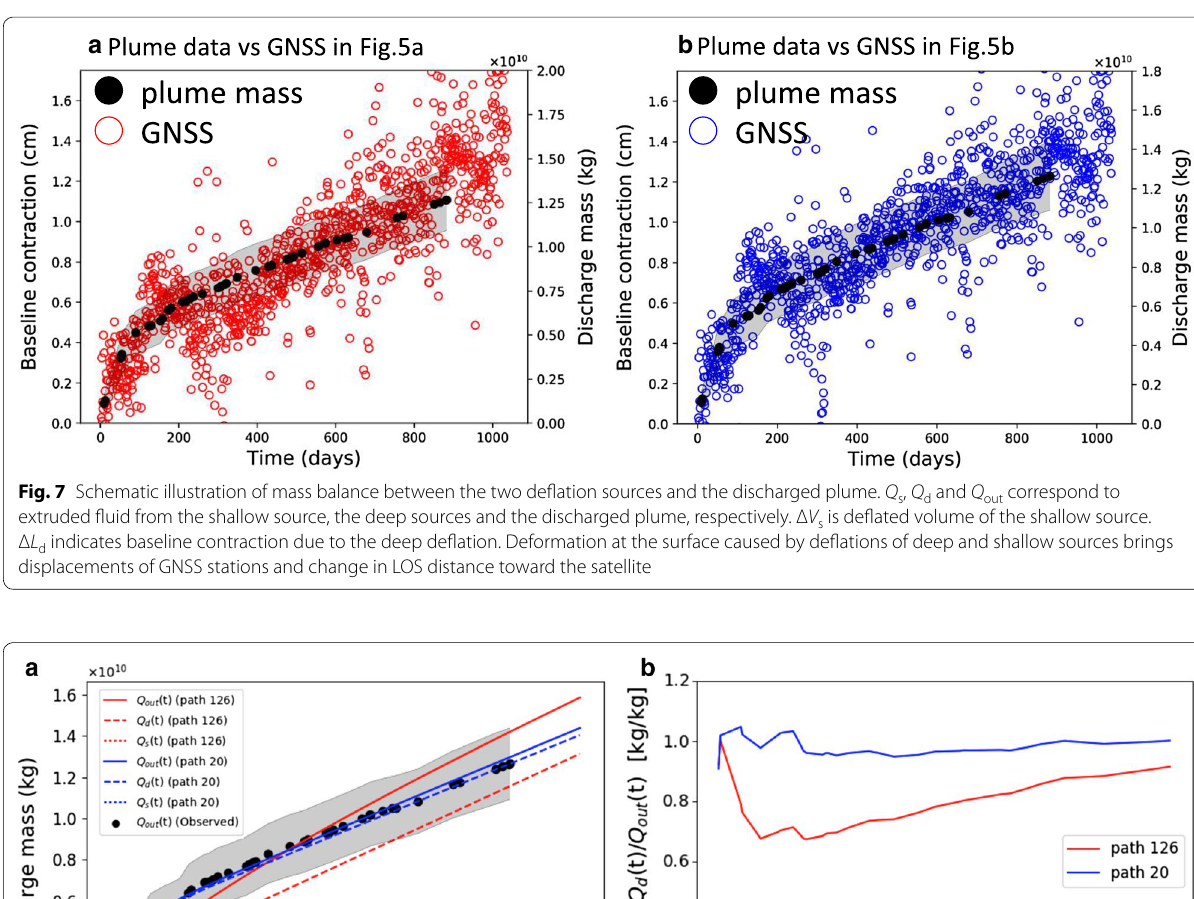
Q d ( t ) Q s ( t )), Q d ( t ) and Q s ( t ). Gray-shaded area = +